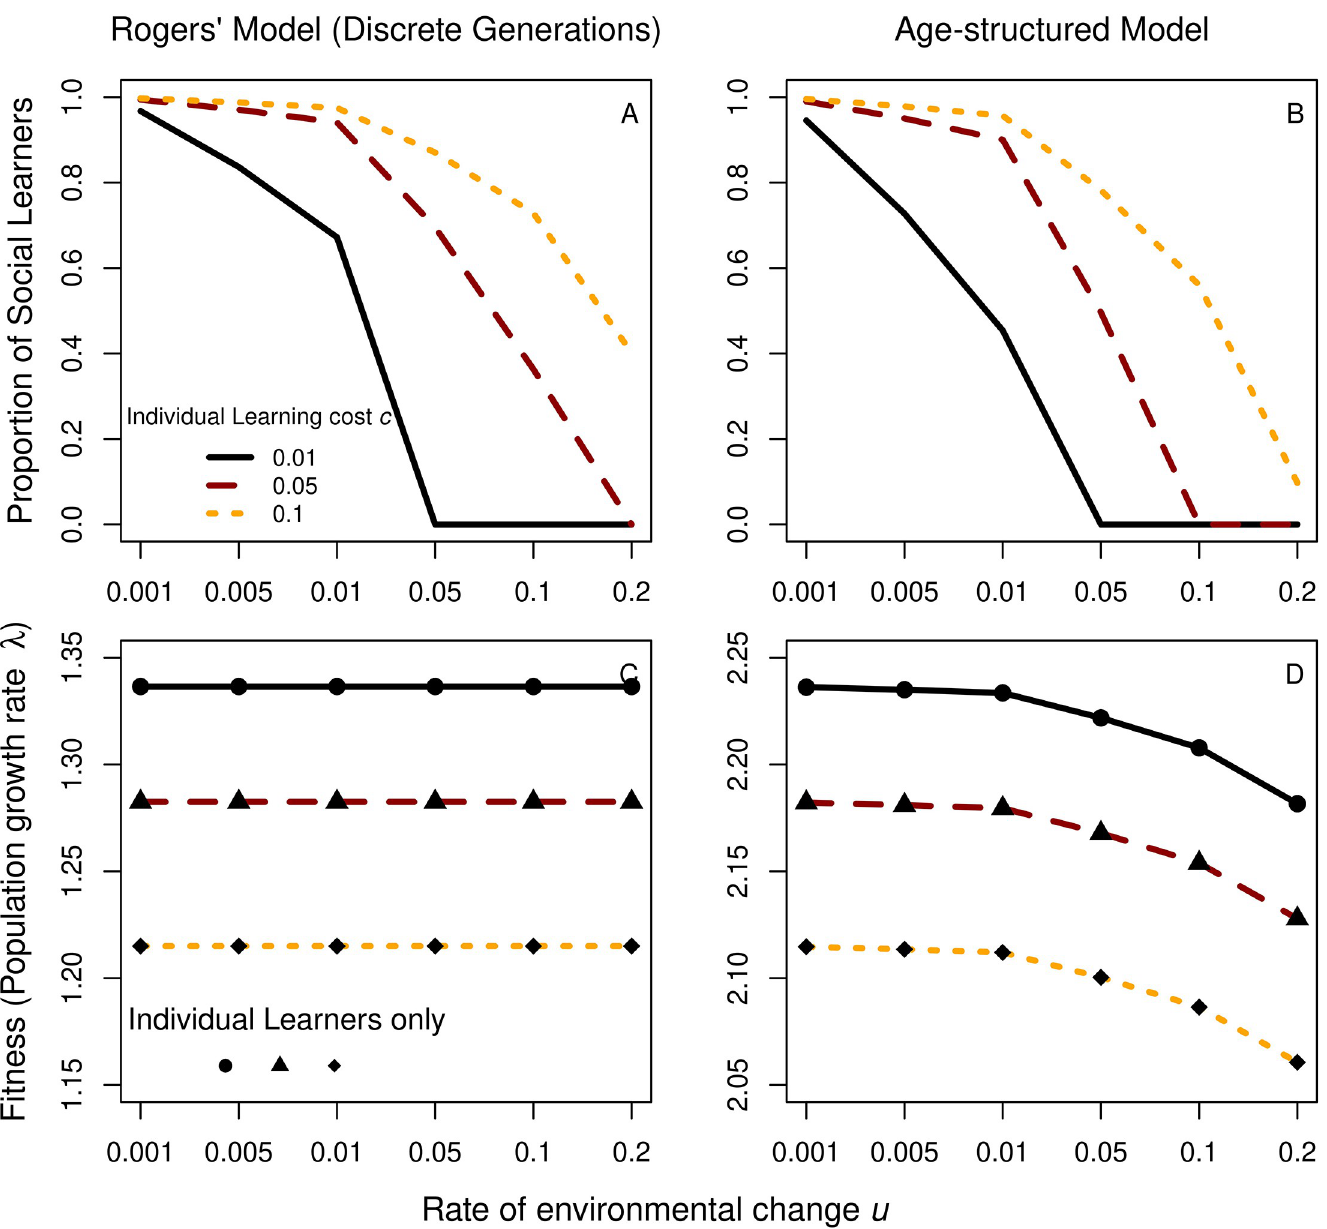
Fig 1. Proportion of social learners (top) and mean population fitness (lineage growth rate at equilibrium λ ; bottom) conditional on the rate of environmental change u and the cost of individual learning c . Results for the original Rogers model with discrete, non-overlapping generations are shown on the left, results for the age- structured model with overlapping generations on the right. Lines in plots C and D represent populations with social learners, black shapes give corresponding values for populations with only individual learners. Other parameter values were: z = 1, ϕ = 1, b 0 = 1, b 1 = 1.5, s 0 = 0.9, s 1 =